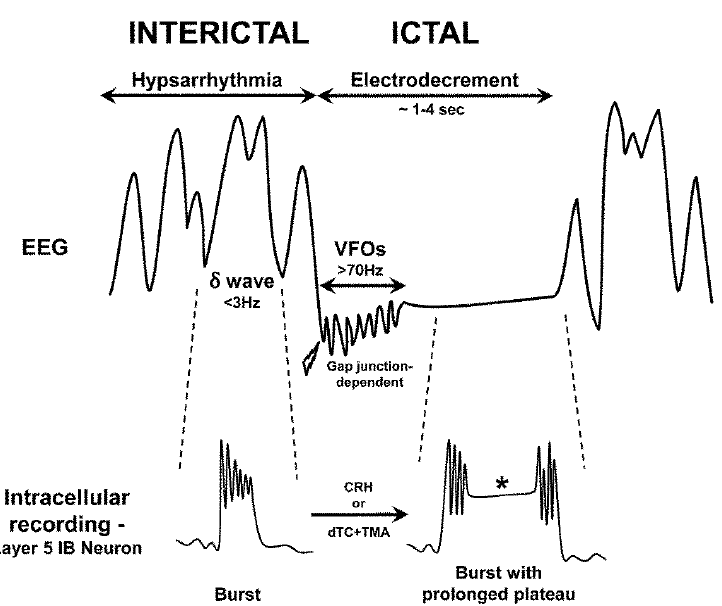
Figure 2. Schematic showing characteristic electroencephalogram (EEG) findings in infantile spasms. Top trace: Hypsarrhythmia (interictal) consists of chaotic, high-voltage irregular slow waves (delta range, δ , <3 Hz) with superimposed sharp waves and spikes. Lightning bolt indicates onset of a clinical spasm. The EEG sometimes exhibits initial very high frequency oscillations (VFOs, >70 Hz) that are mediated by gap junctions, followed by electrodecrement (attenuation of voltage during the clinical spasm). Once the spasm ends, the electrodecrement ceases and hypsarrhythmia resumes. Bottom trace: The cellular correlates of the different phases of the EEG are indicated. During hypsarrhythmia, layer 5 pyramidal neurons (intrinsic bursting (IB) type) fire in bursts, accompanying each EEG delta wave. These bursts require N-methyl-D-aspartate (NMDA) receptors and GABA B receptors. During electrodecrement, delta waves are suppressed and layer 5 IB neurons are further depolarized, leading to prolonged plateau potentials (asterisk). These plateaus are maximized by an intracellular alkaline pH and involve glutamate release and increased Ca 2+ influx. The transition from interictal to ictal firing can be experimentally induced by the endogenous proconvulsant corticotropin-releasing hormone (CRH) or exposure to the combination of d-tubocurarine (dTC, an acetylcholine receptor antagonist) and trimethylamine (TMA, an alkalinzing agent that enhances gap junction opening). Though simplified, this scheme illustrates potential targets for novel therapeutics (see text).